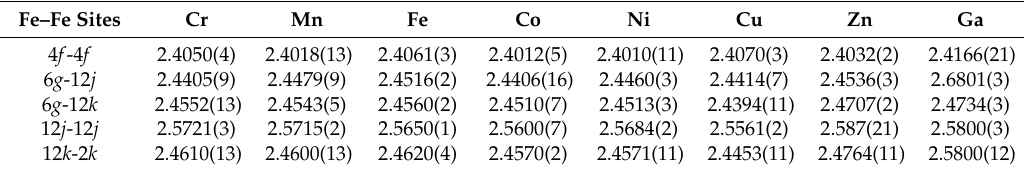
Figure 3. Atomic site–site bond lengths as a function of TM atomic number in Gd 2 Fe 16 Ga 0.5 TM 0.5 (TM = Cr, Mn, Co, Ni, Cu, Zn, and Ga) derived from Rietveld refinement. Table 3. Interatomic Fe–Fe distances (in Å) for Gd 2 Fe 17 and Gd 2 Fe 16 y Ga 0.5 TM 0.5 (TM = Cr, Mn, Co, Ni, Cu, Zn, and Ga) obtained from Rietveld refinement.